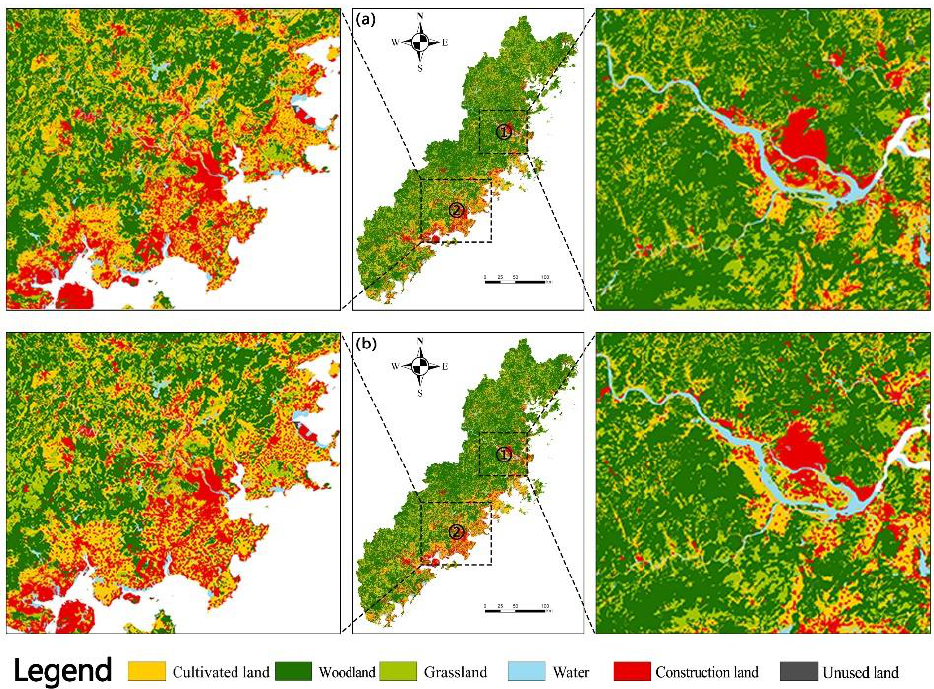
Figure 4. Observed and simulated results of landscape types: ( a ) observed landscape types of 2020; ( b ) simulated landscape types of 2020.